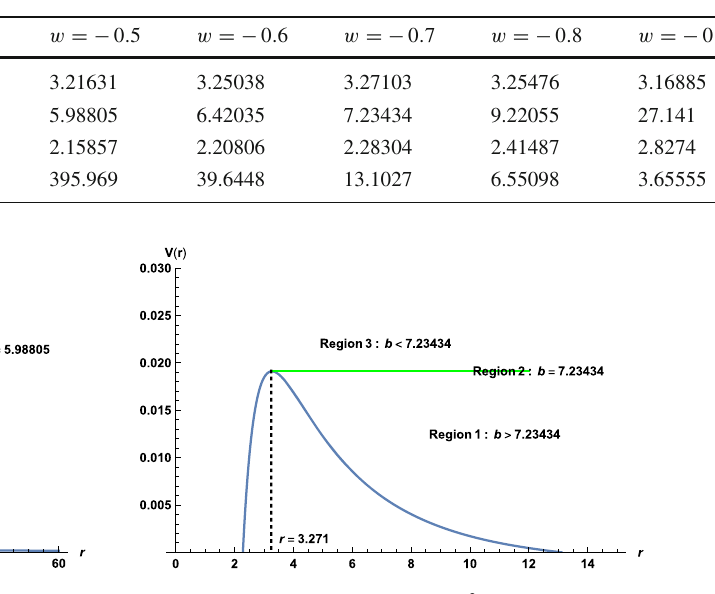
Fig. 1 The profile of the effective potential (blue lines) for w = − 0 . 5 (left panel) and w = − 0 . 7 (right panel) with M = 1 and a = 0 . 05. The dashed lines indicate the radii of the photon sphere r ph . Region 2